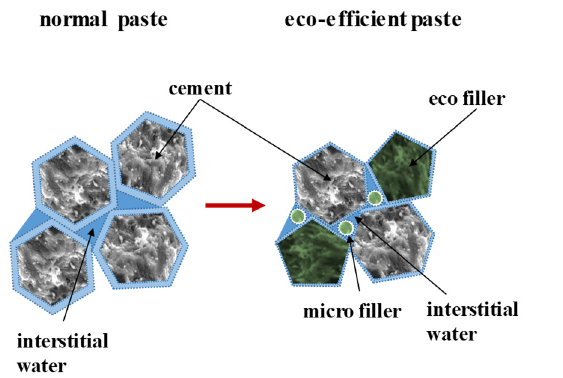
Figure 1. Optimizing paste by using combined fillers: normal paste of PC and water versus eco‐efficient paste with PC and combined fillers (EF, MF). Eco‐paste has enhanced packing density and lower water demand than normal paste for equal flowability as well as reduced environmental impact.